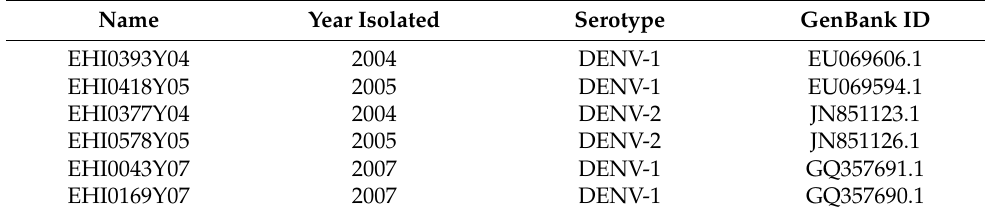
Table 1. Dengue virus field